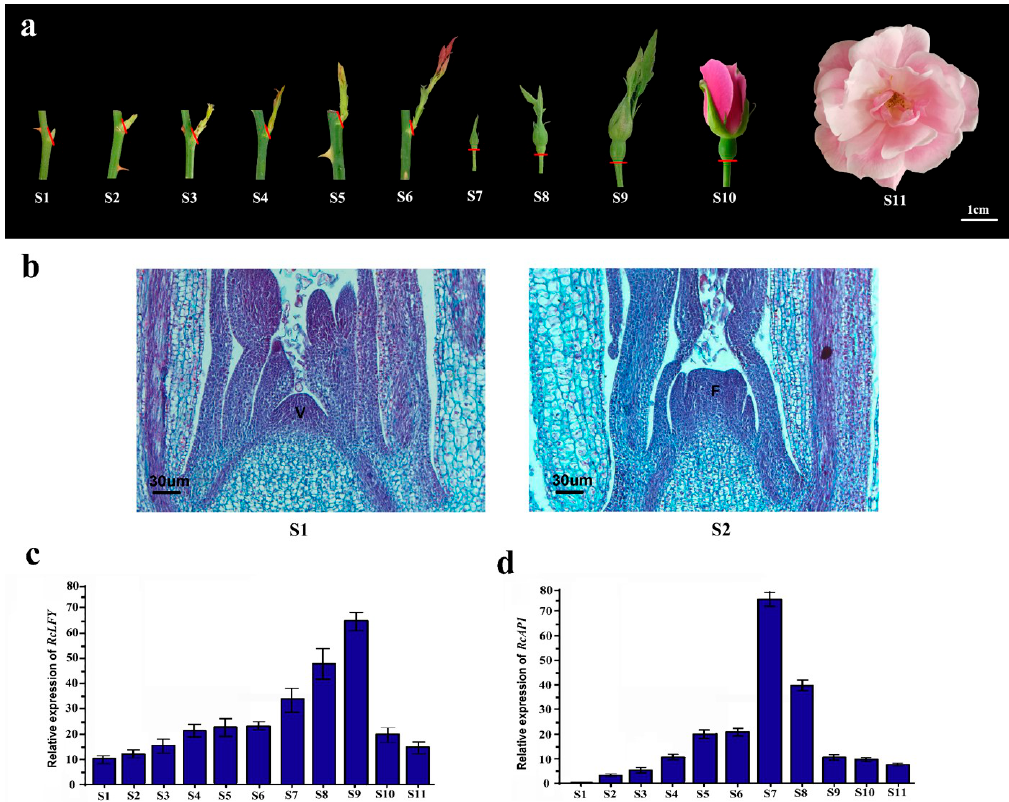
Figure 2. Spatiotemporal pattern of RcAP1 expression in ‘Old Blush’ plants. (a) Photographs of the 11 flower development stages of ‘Old Blush’ plants (S1–S11). S1: vegetative cone and leaf primordia formed; S2: floral meristem formed; S3: sepal primordia formed; S4: petal primordia formed; S5: stamen primordia formed; S6: pistil primordia formed; S7: small flower buds formed (approximately 2 mm diameter); S8: moderate-sized flower buds formed (approximately 4 mm diameter); S9: flower bud differentiation was completed, but sepals did not crack; S10: flowers started to open; and S11: flowers were completely open. Red lines represent the cut marks of the rose parts used for RNA isolation. Scale bar, 1 cm. ( b ) Paraffin sections of ‘Old Blush’ buds stained with toluidine blue in S1 and S2. V, vegetative cone; F, floral meristem. Scale bar, 30 µm. ( c ) Results of a qRT-PCR analysis of RcLFY transcript levels in the 11 rose flower development stages. ( d ) Results of a qRT-PCR analysis of RcAP1 transcript levels in the 11 rose flower development stages. Error bars represent the standard